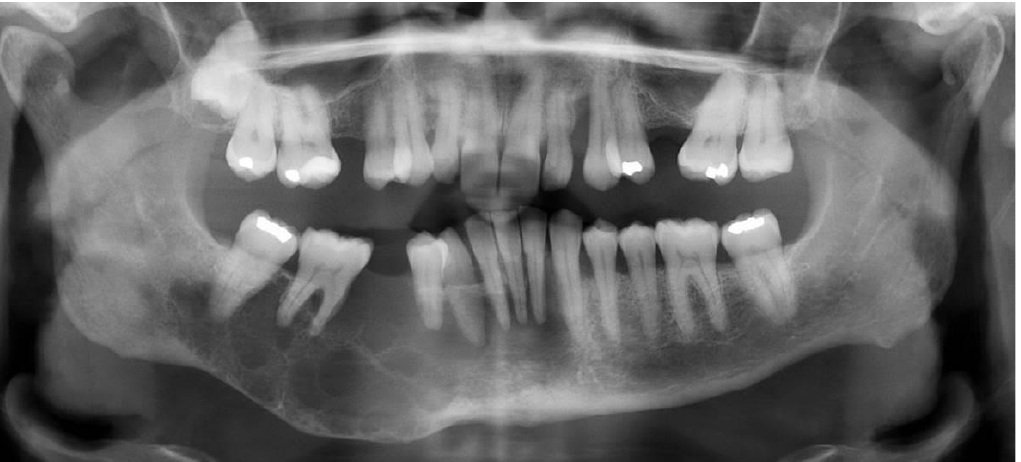
Figure 5. Panoramic X-ray film revealing a 10cm expansile multilocular radiolucency with poorly demarcated borders in the body of the right mandible.